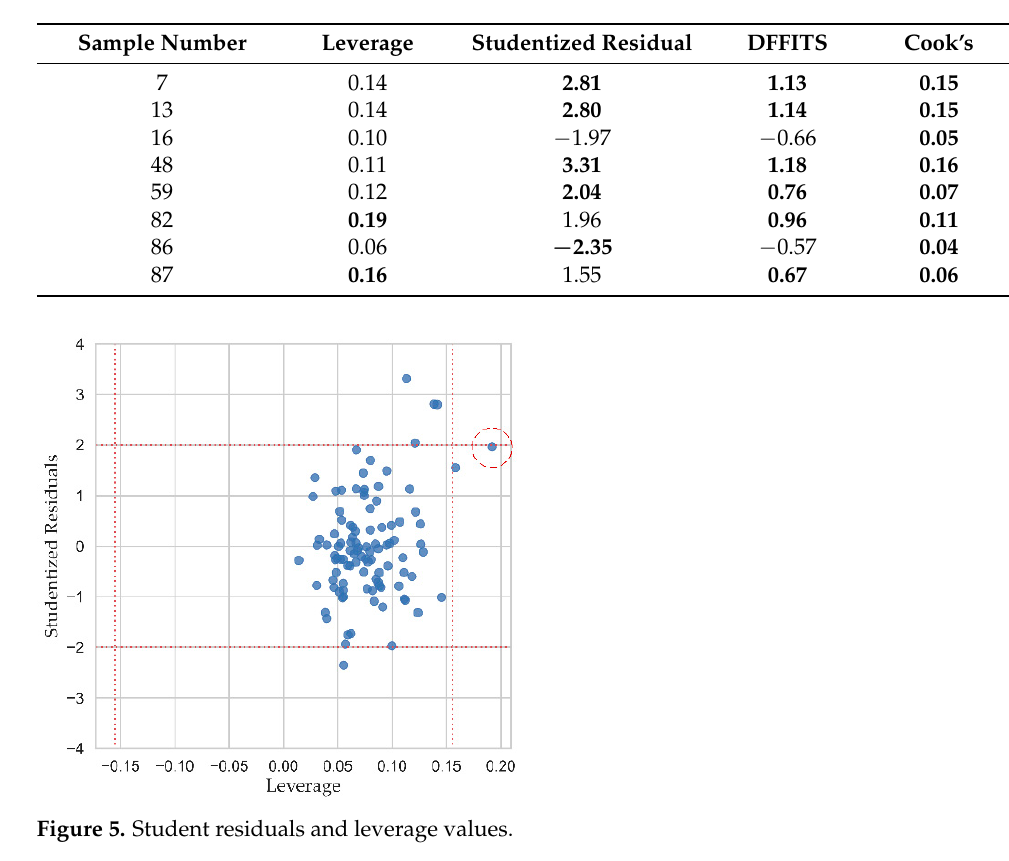
Table 4. Mean replacement, MICE replacement, effect comparison.